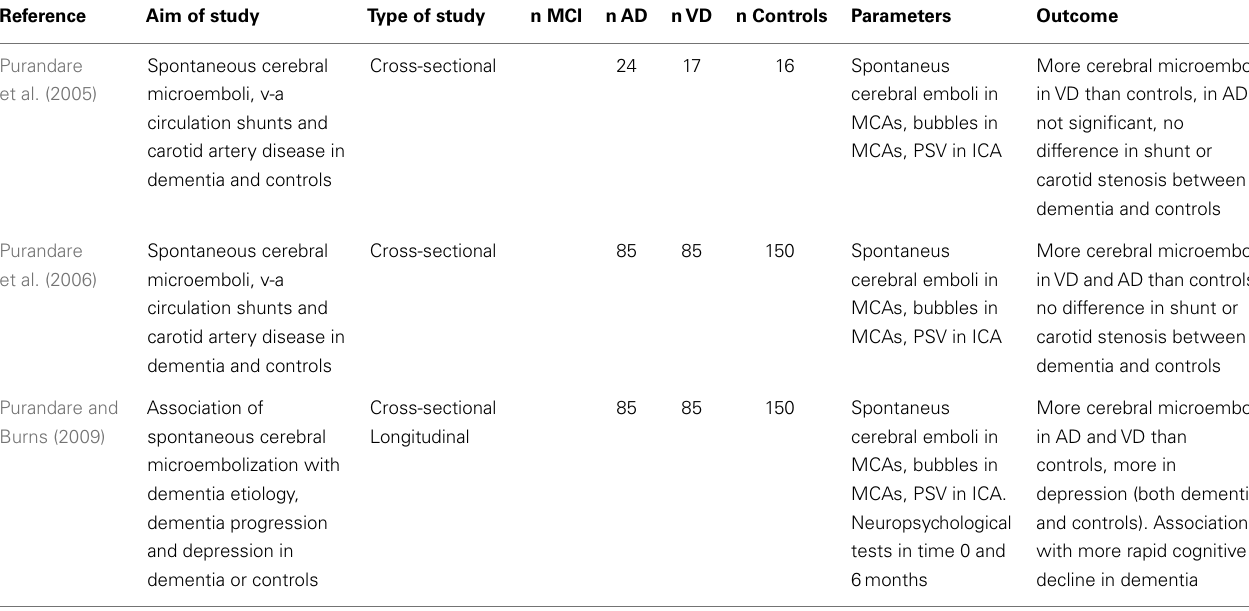
Table 4 | Spontaneous cerebral microembolization and paradoxical embolization via right–left shunts.